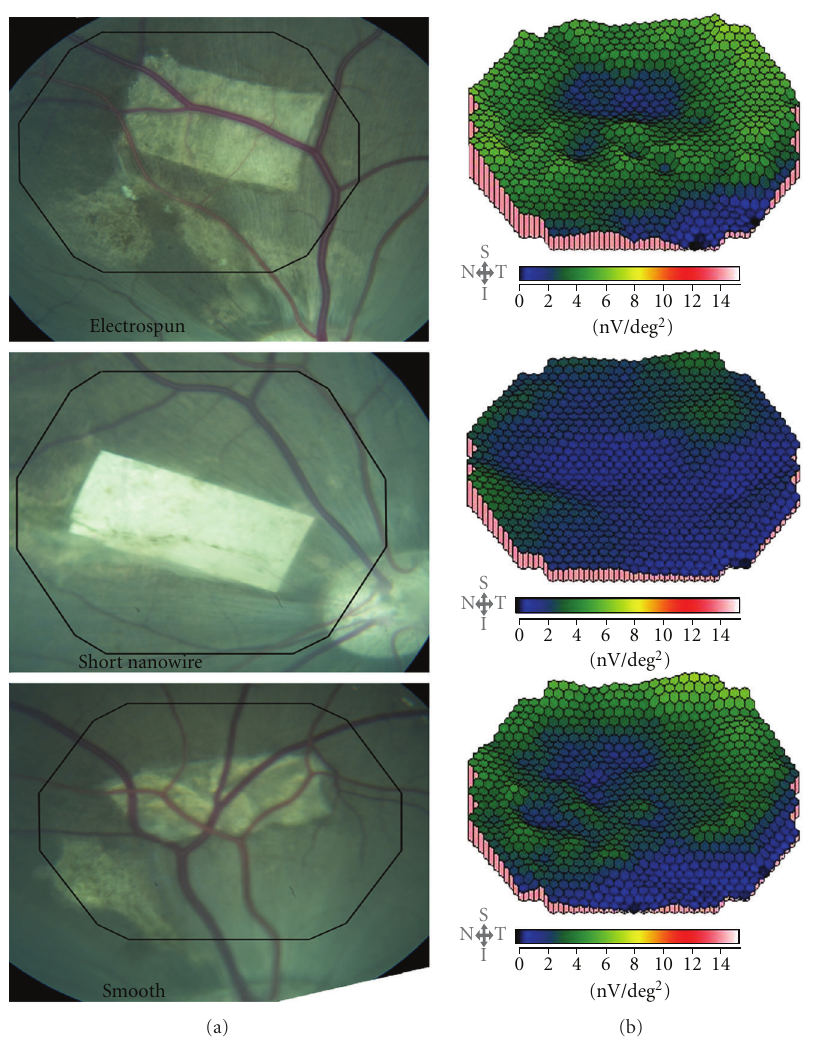
Figure 2: Fundus photos 6 weeks after membrane implantation (a) and corresponding 3D-presentation of amplitudes for the 241 hexagons recorded by multifocal electroretinography (b). Black circle on the fundus photo marks position of the 241-unscaled multifocal electroretinogram-grit. Color scale on the 3D-presentation ranges from 0 to 14 nV/deg 2 . Top: Poly( ε -caprolactone) Electrospun PCL- E) membrane. Middle: Poly( ε -caprolactone) Short Nanowire (PCL-SNW) membrane. Bottom: Poly( ε -caprolactone) Smooth (PCL-S)